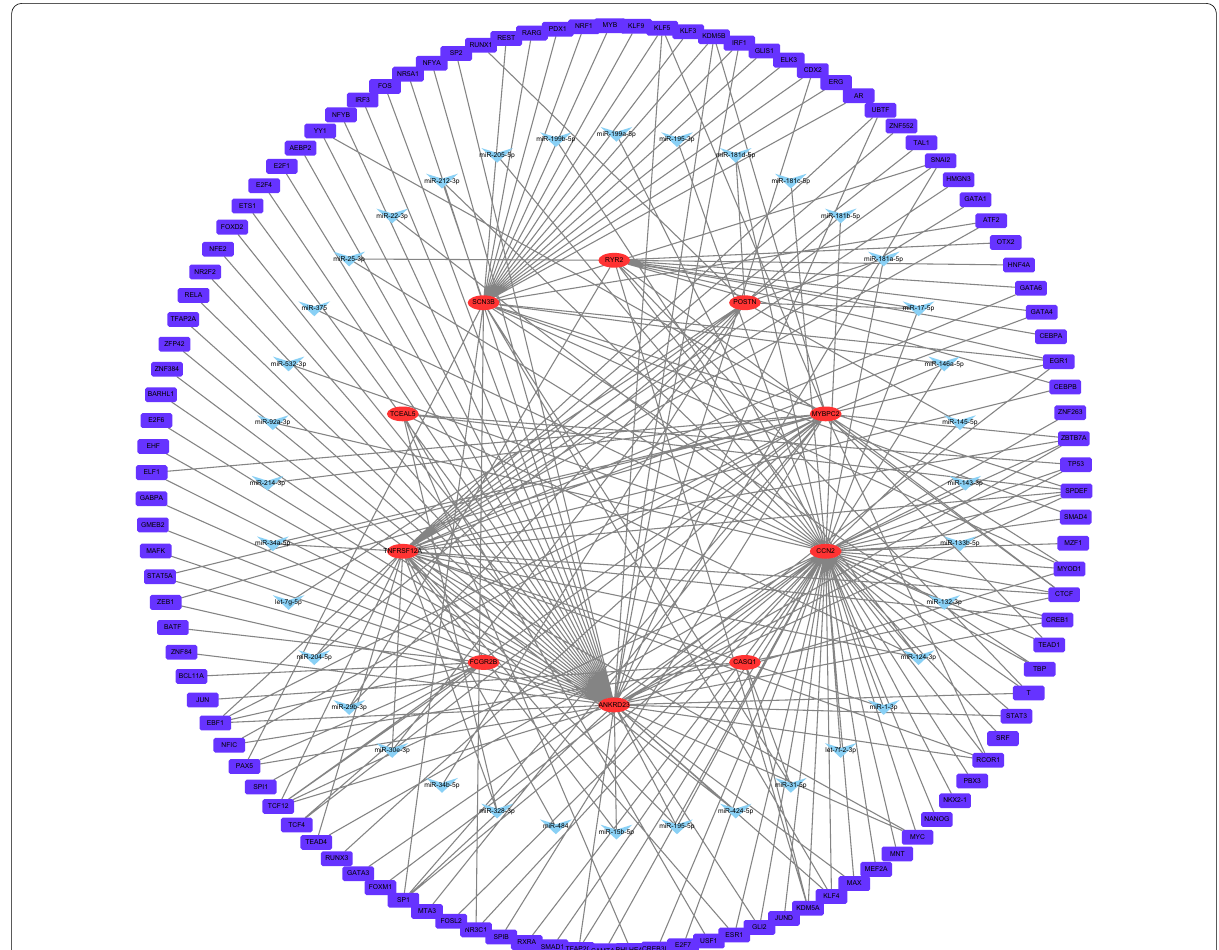
Fig. 7 The miRNA-TF-gene regulatory network. miRNAs targeting the 10 verified core genes were predicted with multiMiR and TF targeting the 10 verified core genes were predicted with ChIPBase v2.0 online